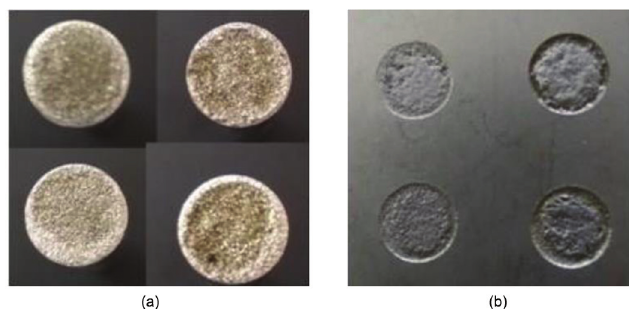
Fig. 3. Images of electrode and workpiece. (a) Electrode surface; (b) Workpiece